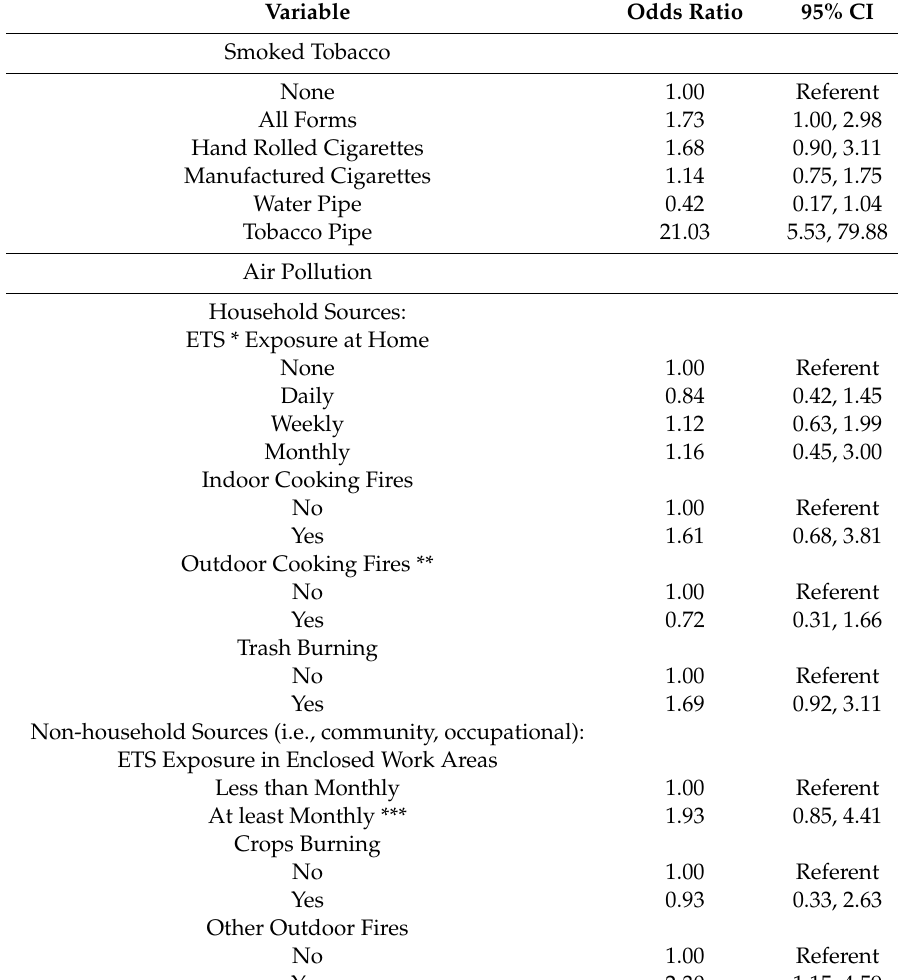
Table 3. Associations between self-reported exposure to tobacco smoke and varied sources of household and non-household air pollution (i.e., smoked tobacco and air pollution) and lifetime history of tuberculosis in 9043 adults (ages 15 and older) of the 2012 National Adult Tobacco Survey of Lao